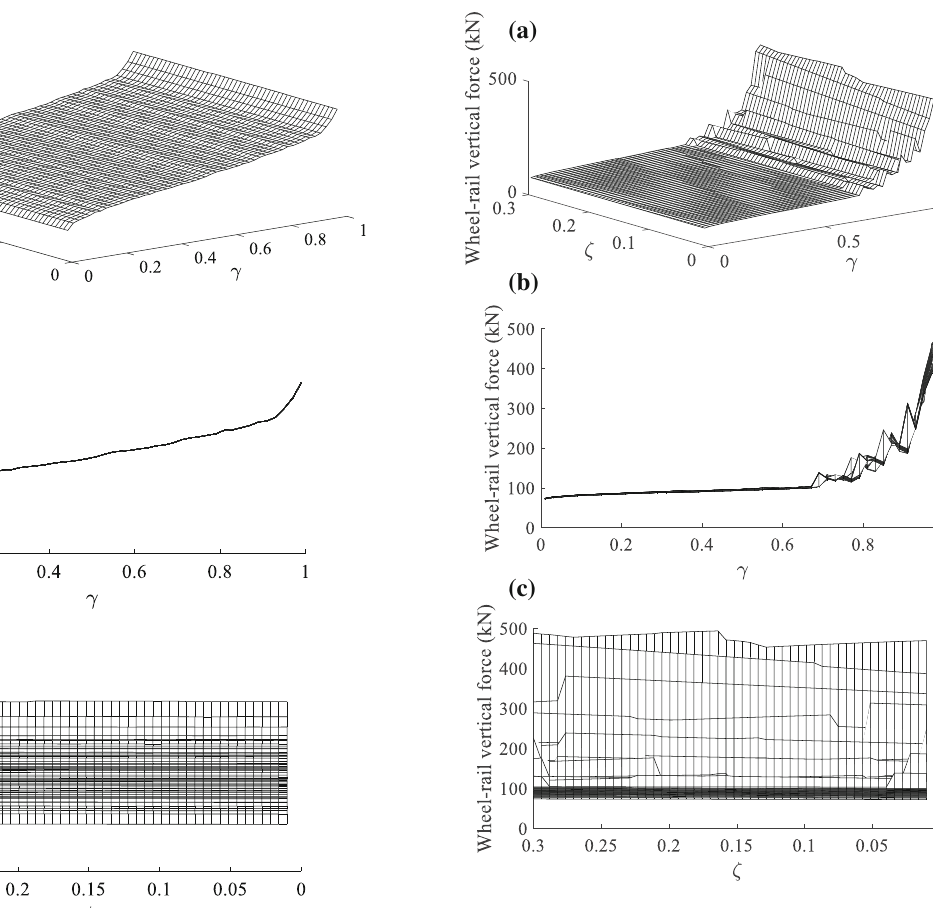
Fig. 17 Wheel–rail vertical acceleration against the changes of track irregularity probability level c and parameter COV f ( a 3D view; b side view; c end